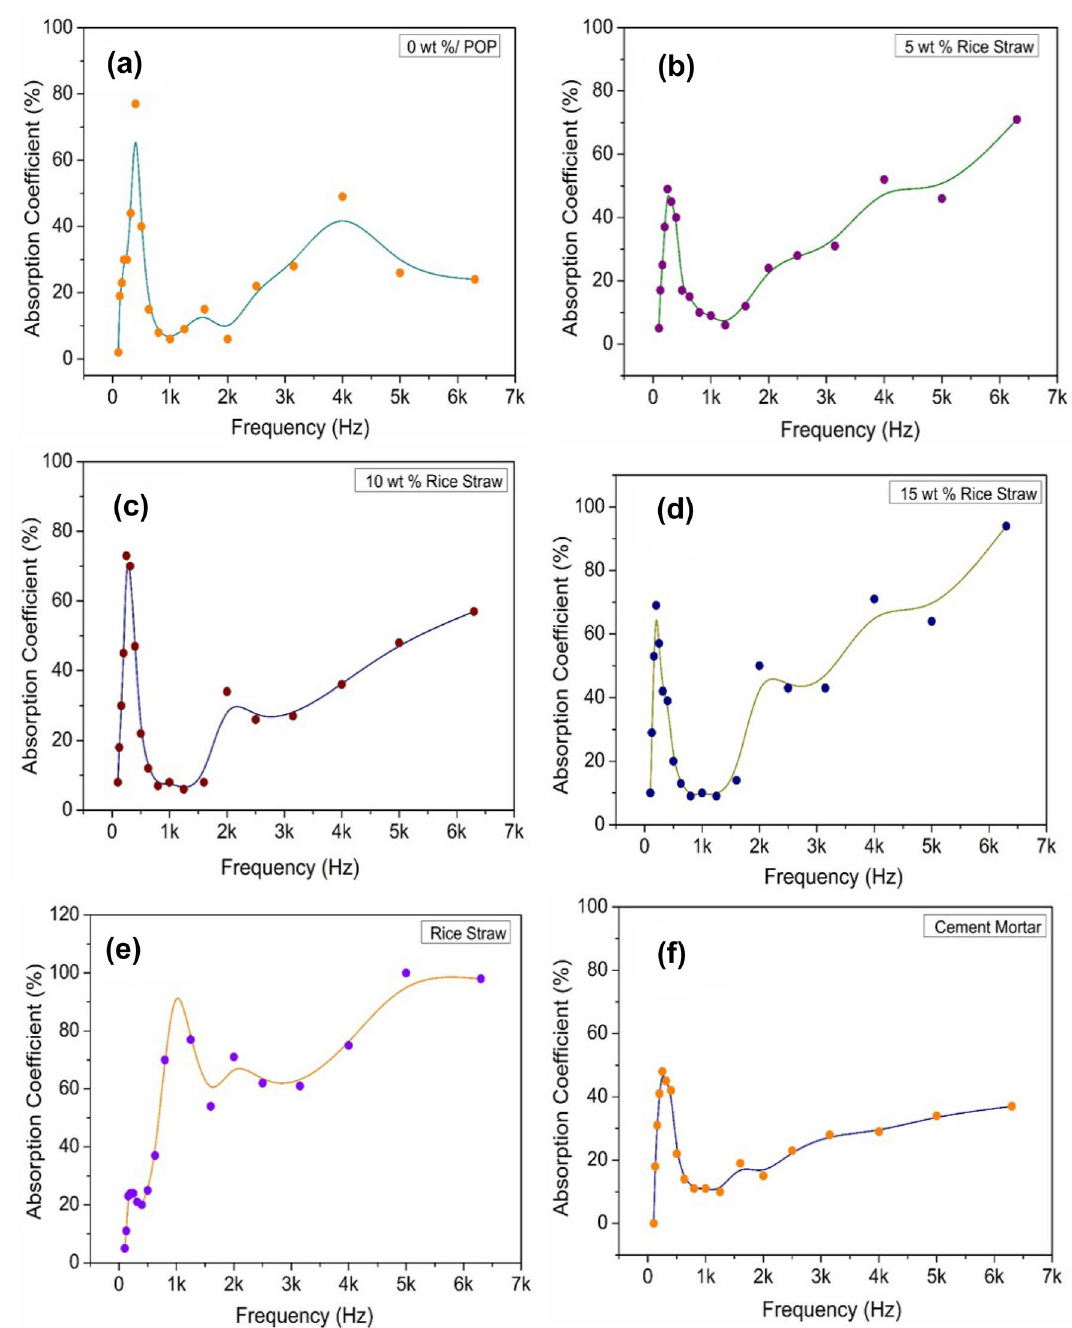
Figure 7. ( a – d ) Sound absorption coefficients of various agro-waste based gypsum samples; ( e ) rice straw; ( f ) cement